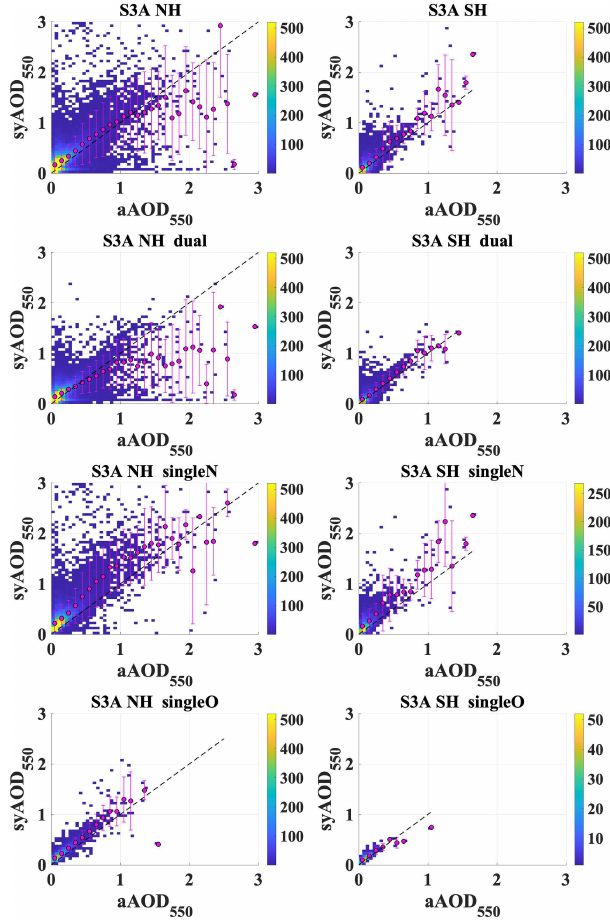
Figure 2. Scatter density plots for S3A syAOD 550 and correspond- ing aAOD 550 for all, dual, singleN, and singleO groups of matchups (panels top-down) available over the NH (left panels) and SH (right panels). The filled magenta circles are the averaged syAOD binned in 0.1 aAOD intervals, and the vertical lines on each circle represent the 1 σ standard deviation of the